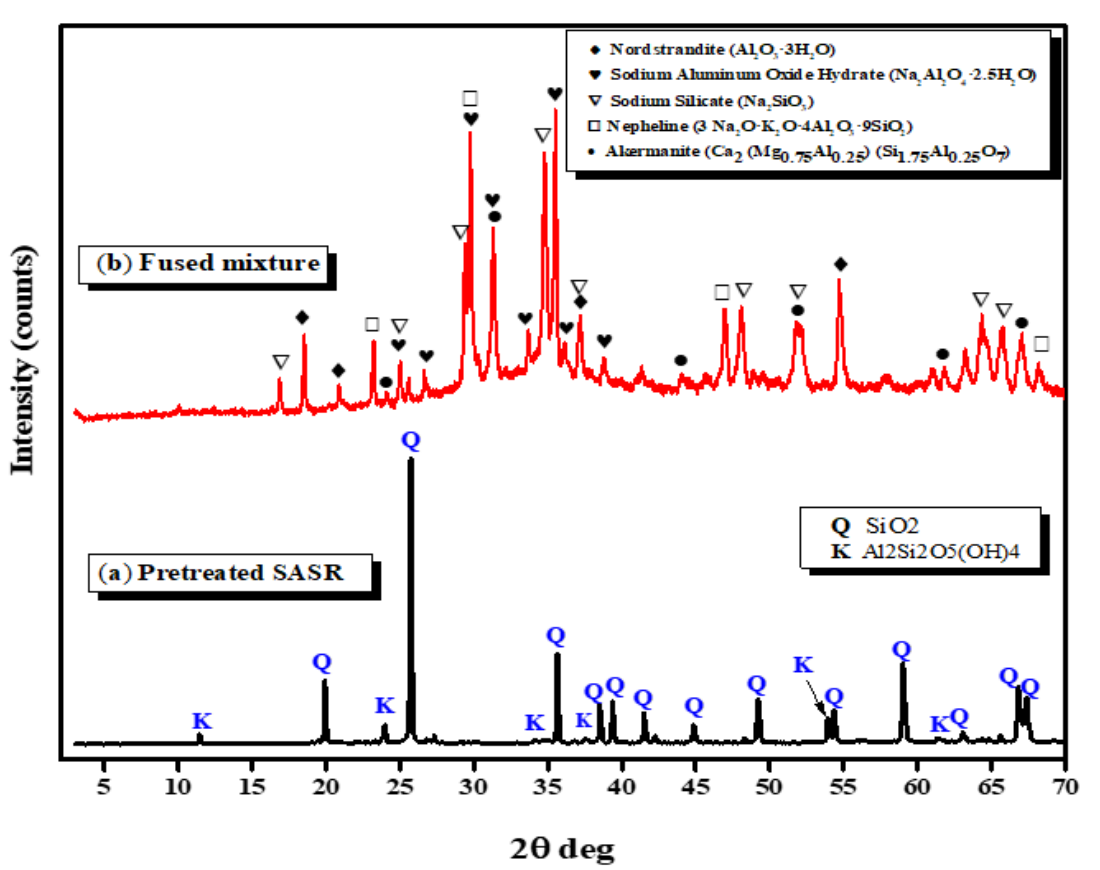
Figure 1. XRD patterns of the pretreated SASR ( a ), and the obtained fused mixture (1:1.5 SASR-Kaolin weight ratio) ( b ). Figure 2 illustrates the mineralogical structure of the produced synthesized zeolite by mixing pretreated SASR and kaolin mixtures at different weight ratios in the presence of Fusion at 600 NaOH (Mixture-NaOH mass ratio of 1:1.3). Figure 2A shows that Faujasite zeolite (Na 2 NaOH + x Al 2 O 3 × y SiO 2 Al 2 Si 3.8 O 11.63 · 8H 2 O) was formed as the major mineral phase from SASR-Kaolin weight ratios of 1:0, 1:2, 1:1.5, 1:1, and 2:1. However, the intensity of its peaks increased with increases of the mass of kaolin, and a high rate of crystallinity (85.21%) can be obtained when the ratio of SASR to kaolin is 1:1.5, due to the stability of the zeolite composition. A percentage of sodalite zeolite (Na 8 (AlSiO 4 ) 6 (OH) 2 · 4H 2 O) groups also existed at a SASR- Kaolin weight ratio of 0:1. Figure 2B shows that the crystallinity of the synthesized zeolite decreased from 85.21% to 69.76% at a 1:2 mixture-NaOH weight ratio. However, when the alkalinity of the system is too high, a decline in crystallinity is caused. This can be attributed to one of the following two reasons: either the created zeolite spontaneously transforms into hydroxyl sodalite, which has a greater thermodynamic stability [26]; or the zeolite will dissolve in the hot alkali solution because of its metastable state